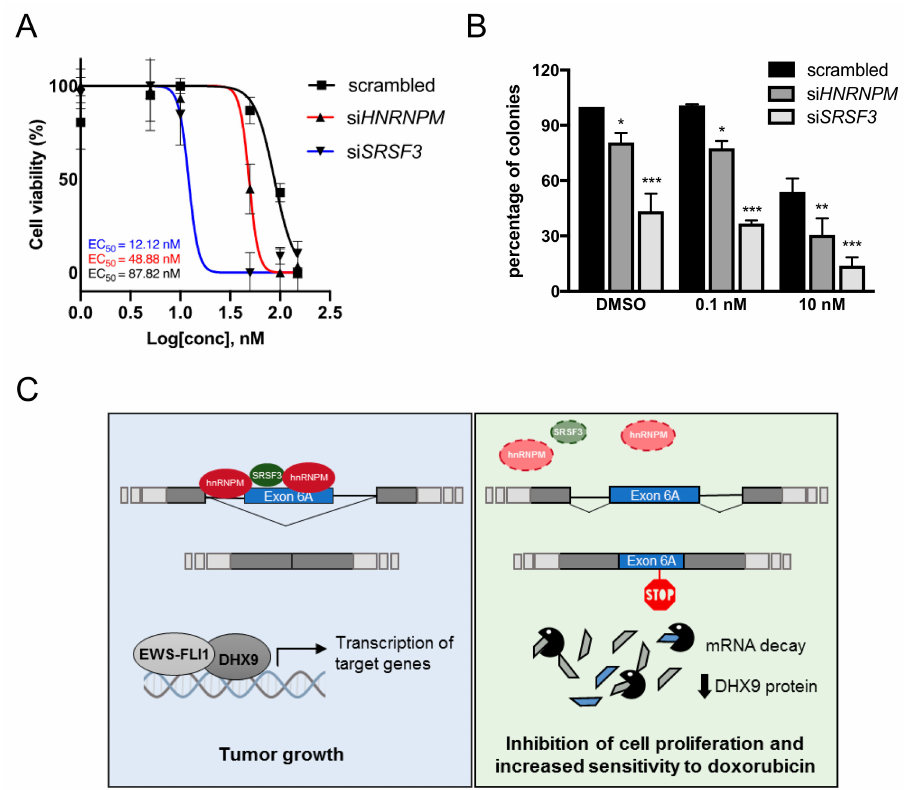
Figure 6. Depletion of SRSF3 and hnRNPM increases doxorubicin sensitivity of Ewing sarcoma cells. (A ) Dose-response curve of scrambled (black), siHNRNPM (red), and siSRSF3 (blue) TC-71 cells after treatment with increasing concentration of doxorubicin (from 0 to 150 nM). Cells were collected at 72 h after treatment. EC 50 values are reported on the bottom. ( B ) Colony assay of scrambled, siSRSF3, and siHNRNPM TC-71 cells treated with increasing concentration of doxorubicin (from 0.1 nM to 10 nM in DMSO). Histogram shows the percentage of colonies determined 12 days after treatment. Statistical analysis was performed by two-way ANOVA. Asterisks indicate significance with Bonferroni post-hoc test ( p -value: *** < 0.001, ** < 0.01, * < 0.05). ( C ) Graphical representation of the hypothetical